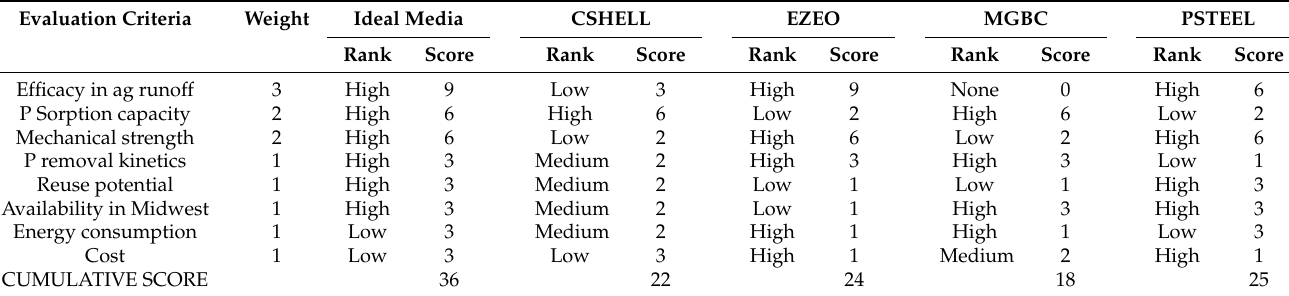
Table 3. Filter media screening scores for ideal and evaluated